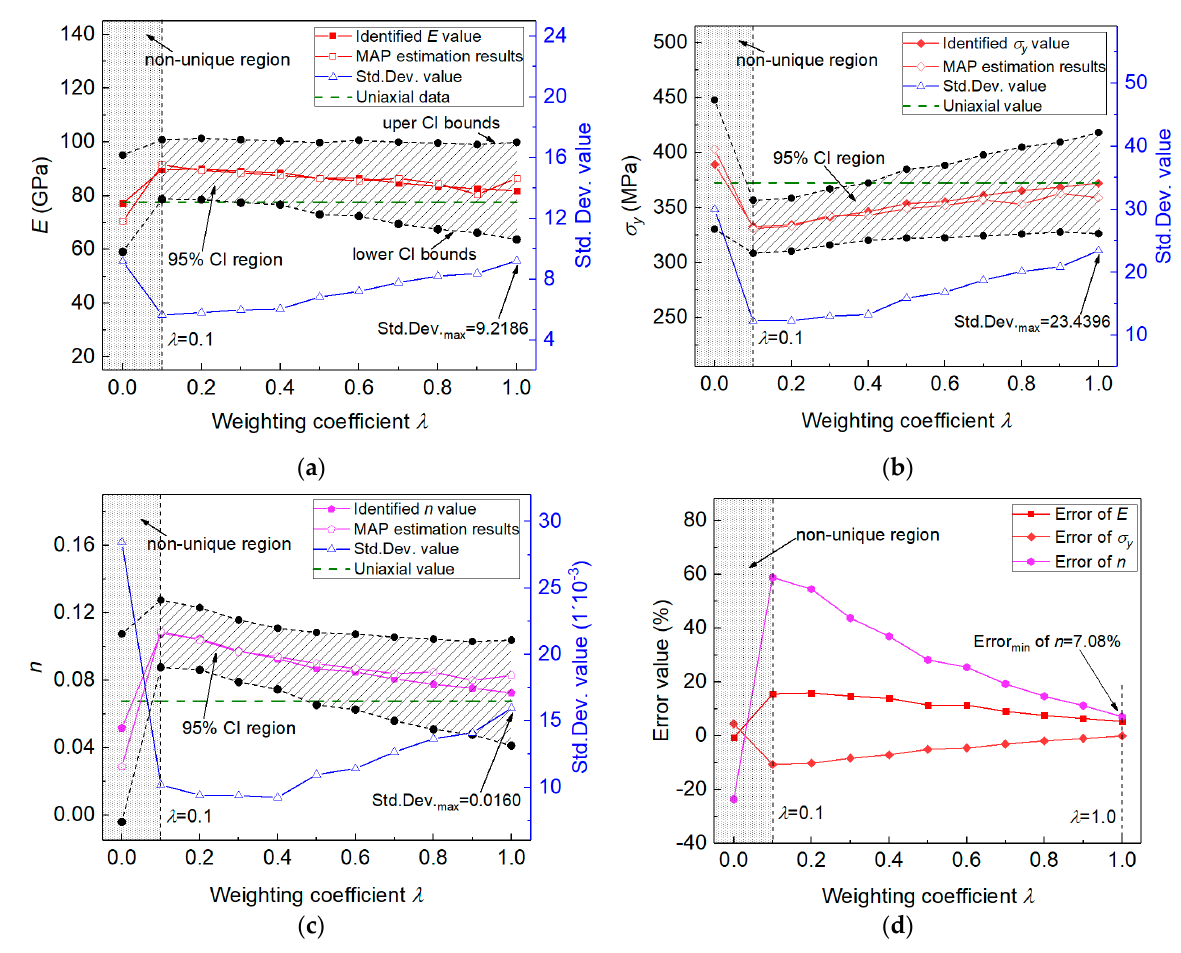
Figure 13. Influence of the weighting coefficient on estimation results of the elastoplastic properties: in ( a ) for 𝐸 ; in ( b ) for 𝜎 (cid:3052) ; in ( c ) for 𝑛 and in ( d ) for the estimation errors.